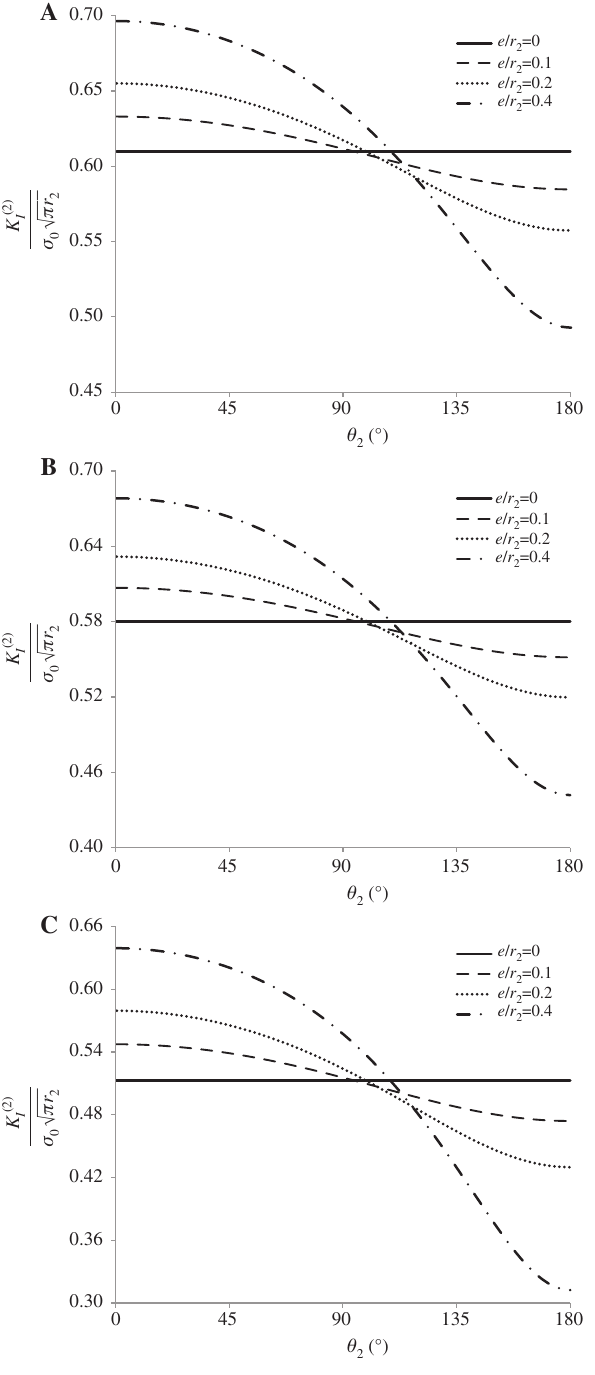
Figure 5: Effect of the eccentricity on the outer stress intensity factor for the cases: (A) r